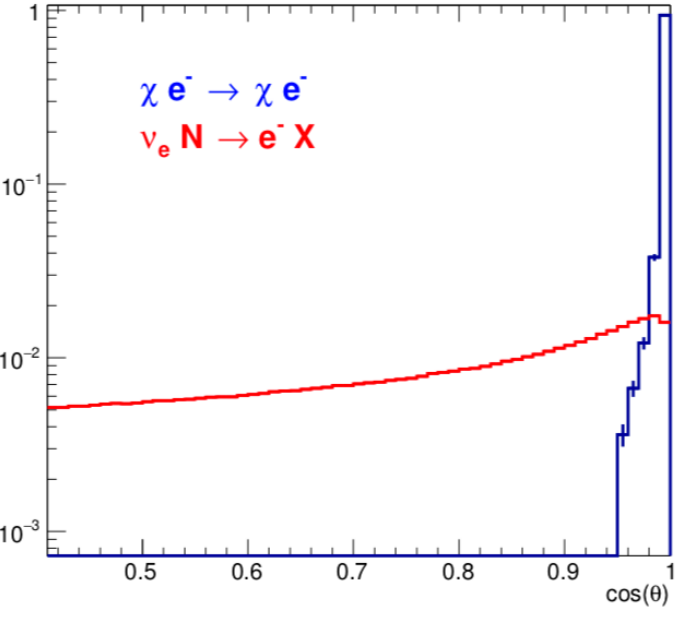
Figure 5. Scattered electron angle distribution for the signal χ e − → χ e − and ν e CC background. The two histograms have been scaled to the same unitary